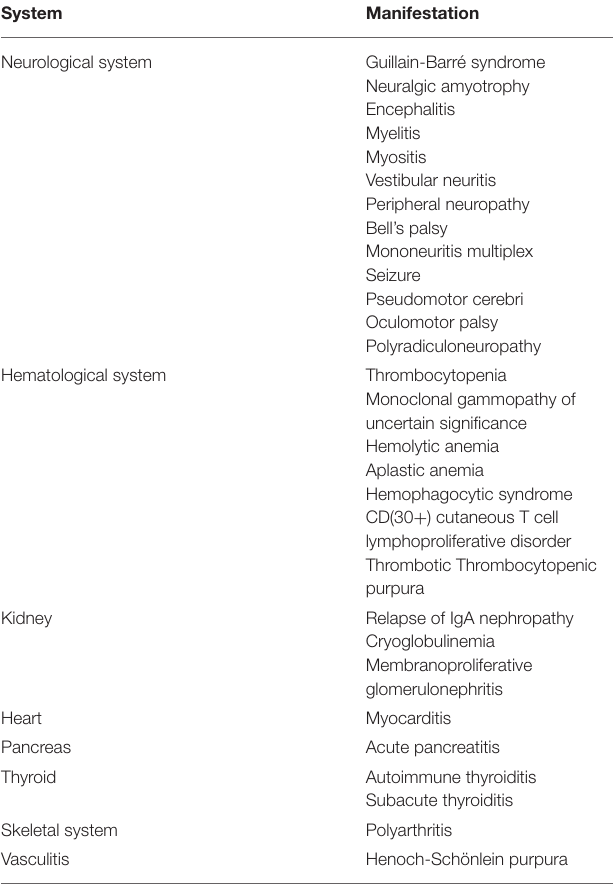
TABLE 4 | The extrahepatic manifestations encountered in patients with HEV infection.